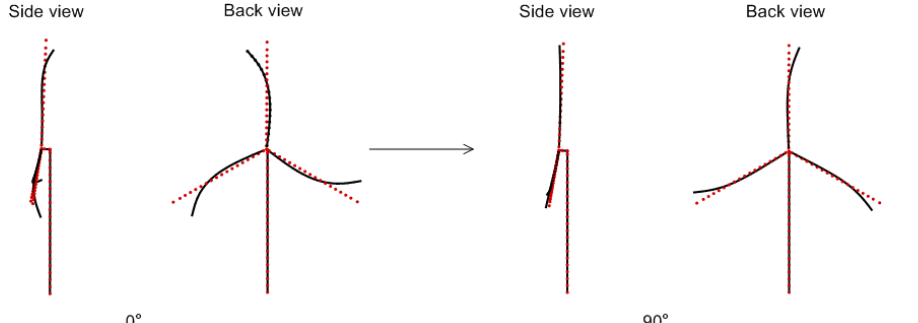
Figure 4. Mode shape alternation from 0 to 90 ◦ pitch for symmetric in-plane mode M8. The red symbols indicate an undeformed state, and the black lines indicate a deformed